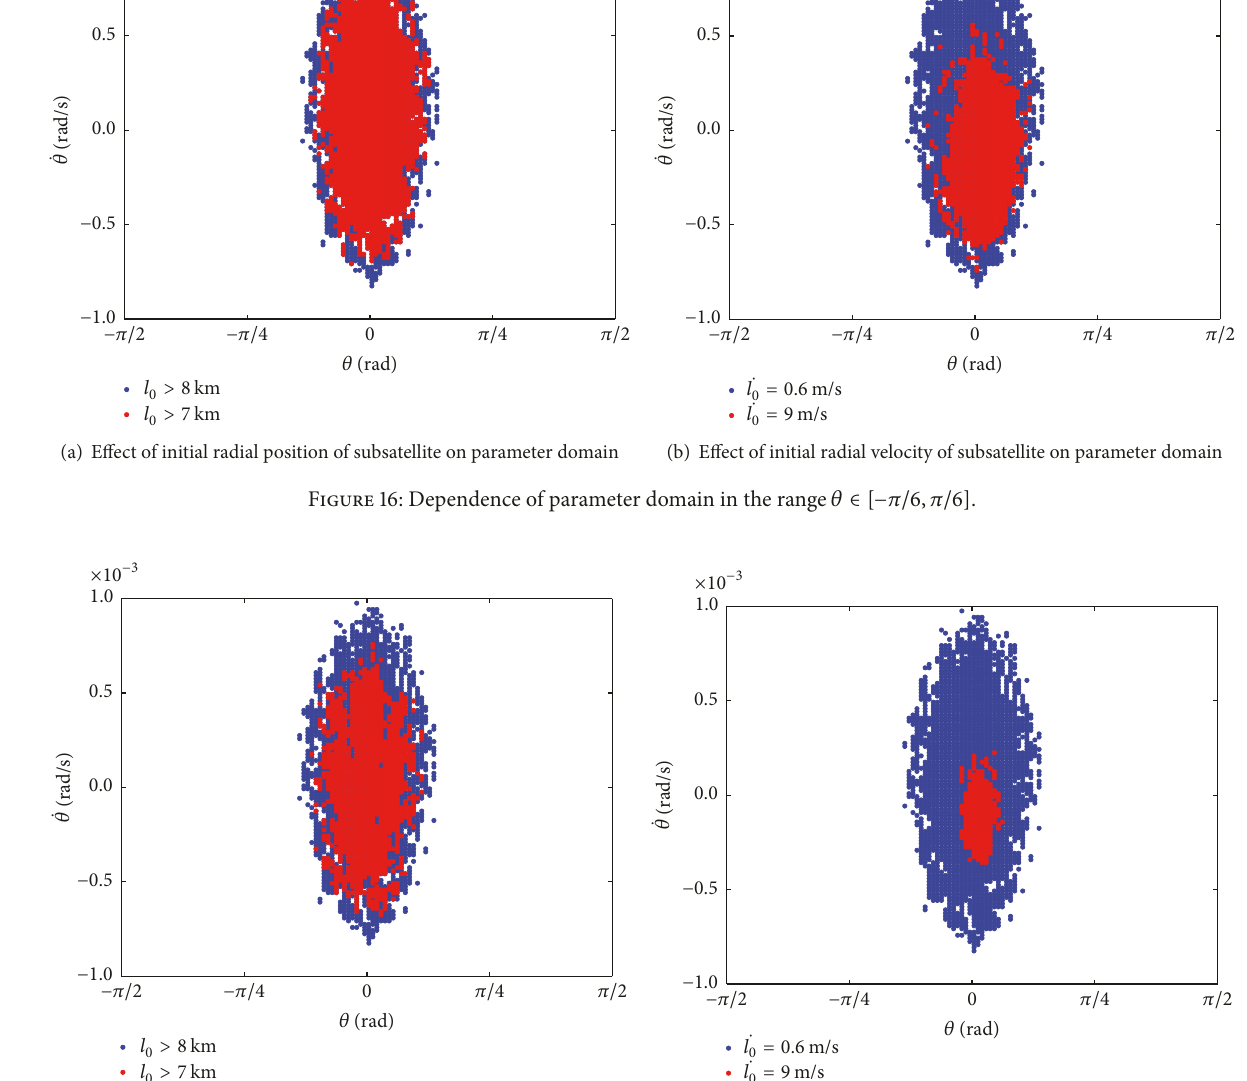
Figure 17: Dependence of parameter domain on radial impact velocities